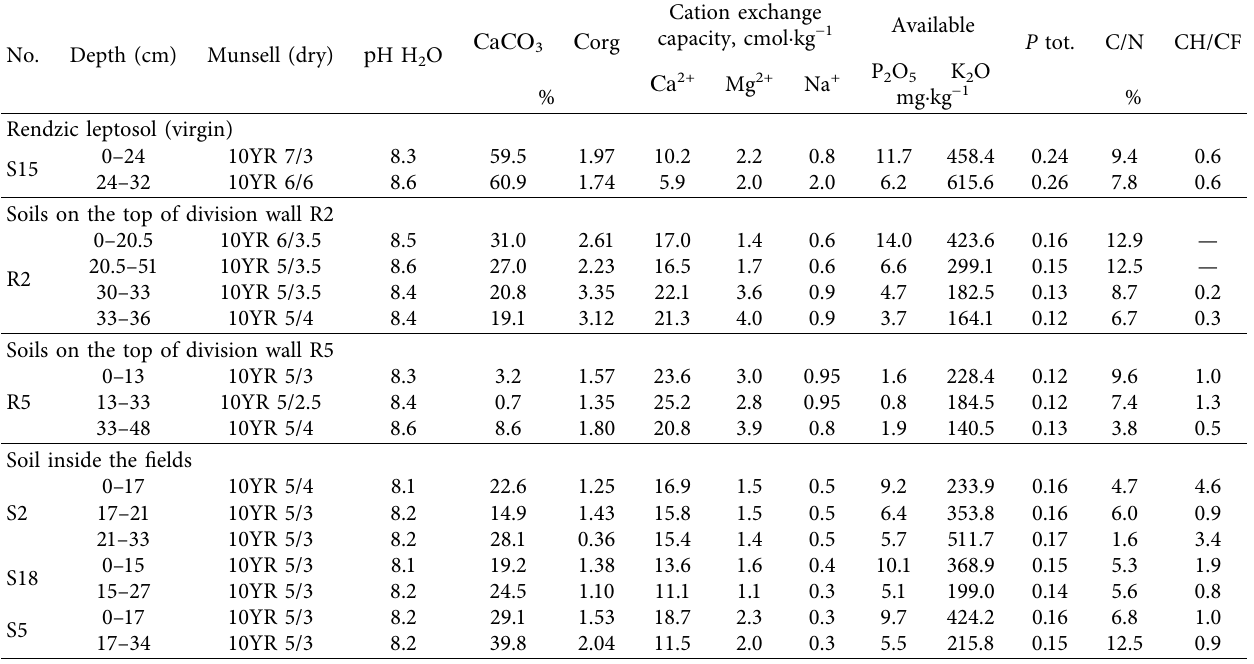
Table 3: Chemical properties of soils atop the division walls (R2, R5), inside the fields (S2, S5, S18), and in virgin conditions (S15). No. Depth (cm) Rendzic leptosol